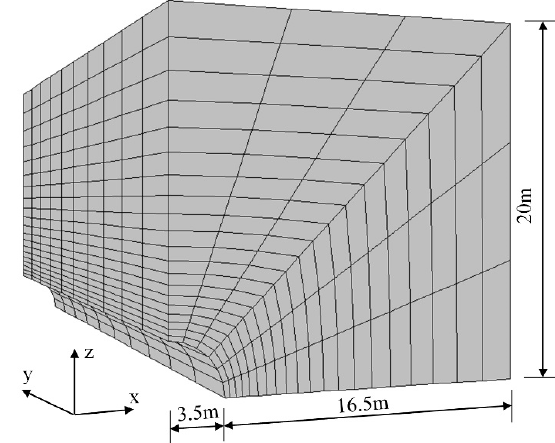
Figure 9. Computational grid of FLAC 3D .